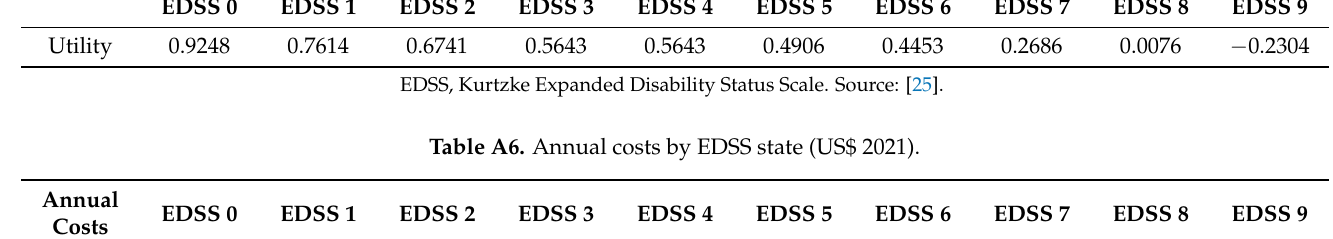
Table A6. Annual costs by EDSS state (US$ 2021).